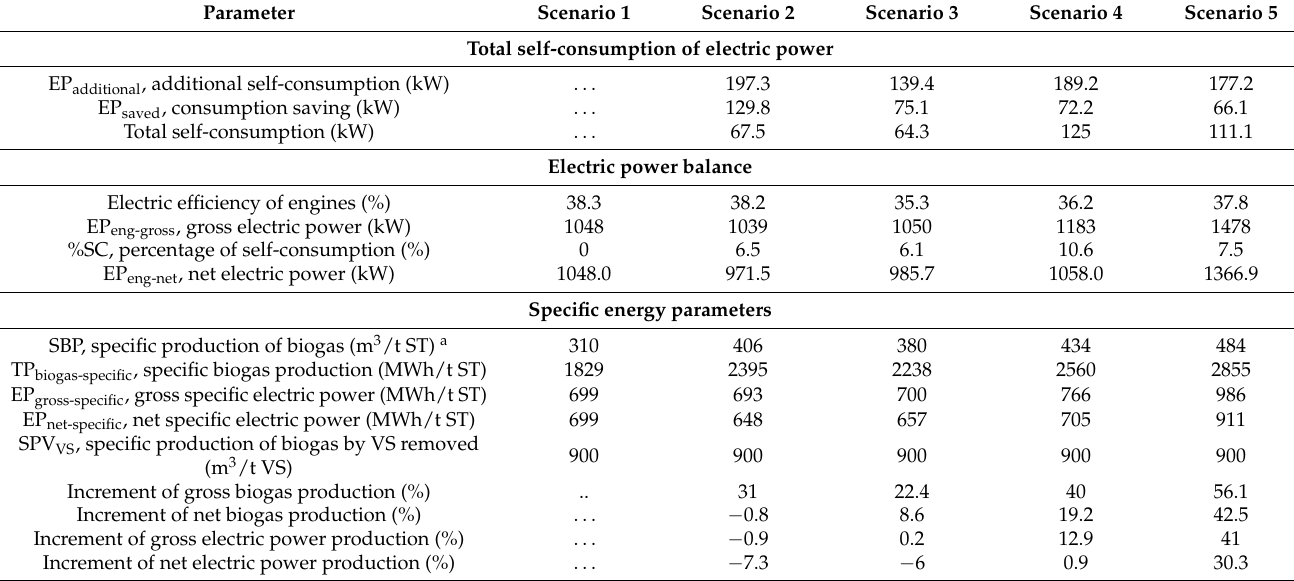
Table 8. Total self-consumption, electric power and specific energy parameters obtained from the economic balance under the assumptions of Case